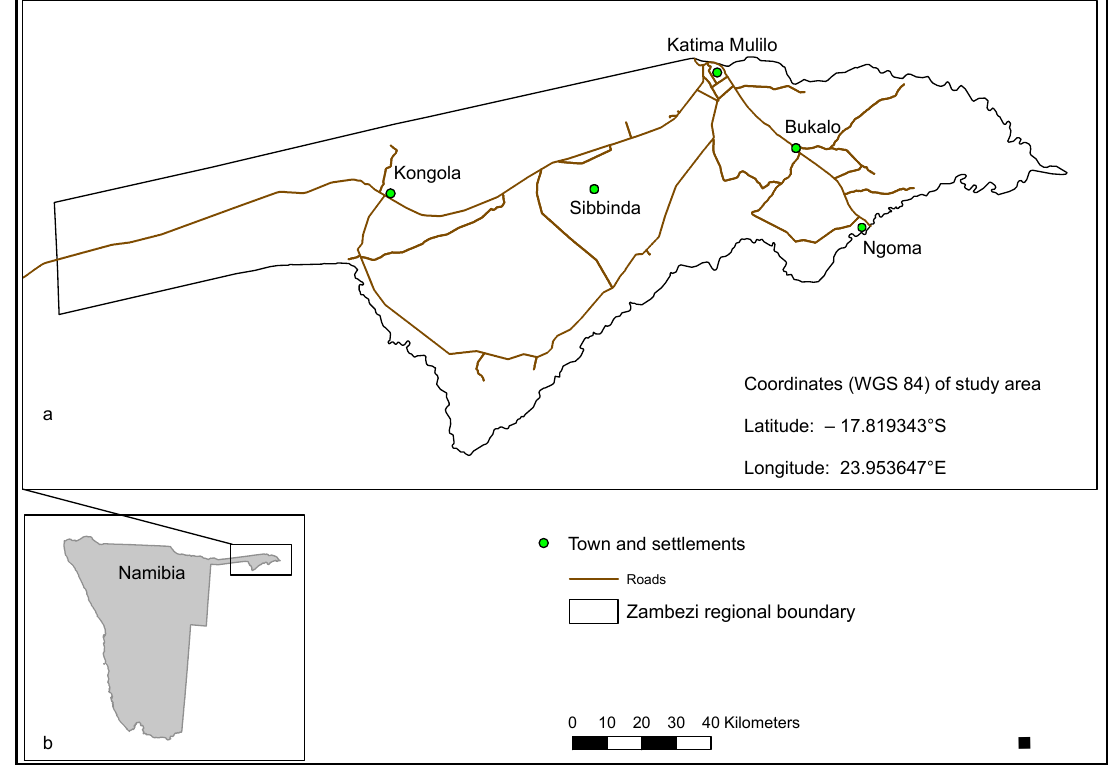
Figure 1. Location of study area, the Zambezi region ( a ), in Namibia ( b ) showing main roads, towns and settlements.